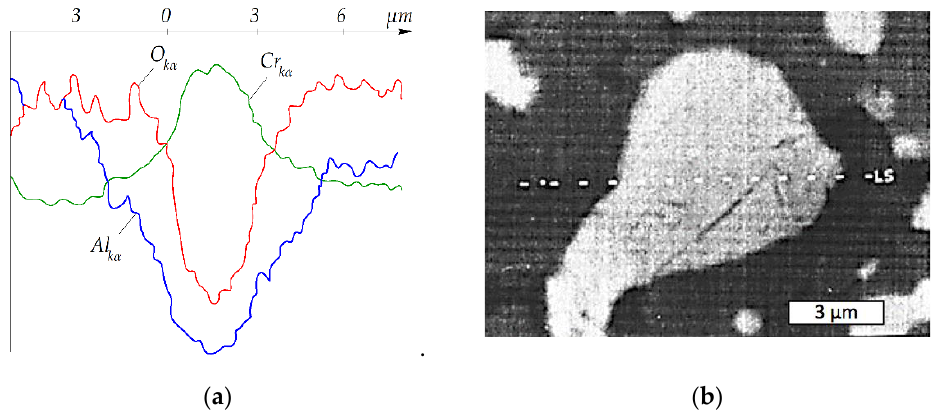
Figure 4. Qualitative distribution of the elements at the phase boundaries in the Cr 2 O 3 + (Cr,Al) 2 O 3 + 22 wt.% Cr sample sintered out of Cr 2 O 3 + 13 wt.% Al powder at Т = 1400 °С and Р = 30 MPa for t = 10 min: ( a ) diagram; ( b ) SEM image of the analyzed sample.